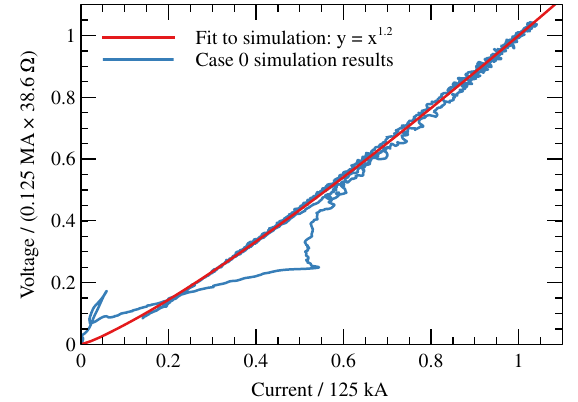
FIG. 13. Comparison between voltage and total current, for simulation Case 0. The part of the simulation pulse that lies farthest from the fit is from early in the pulse, before the flow current is established and while the voltage is still relatively